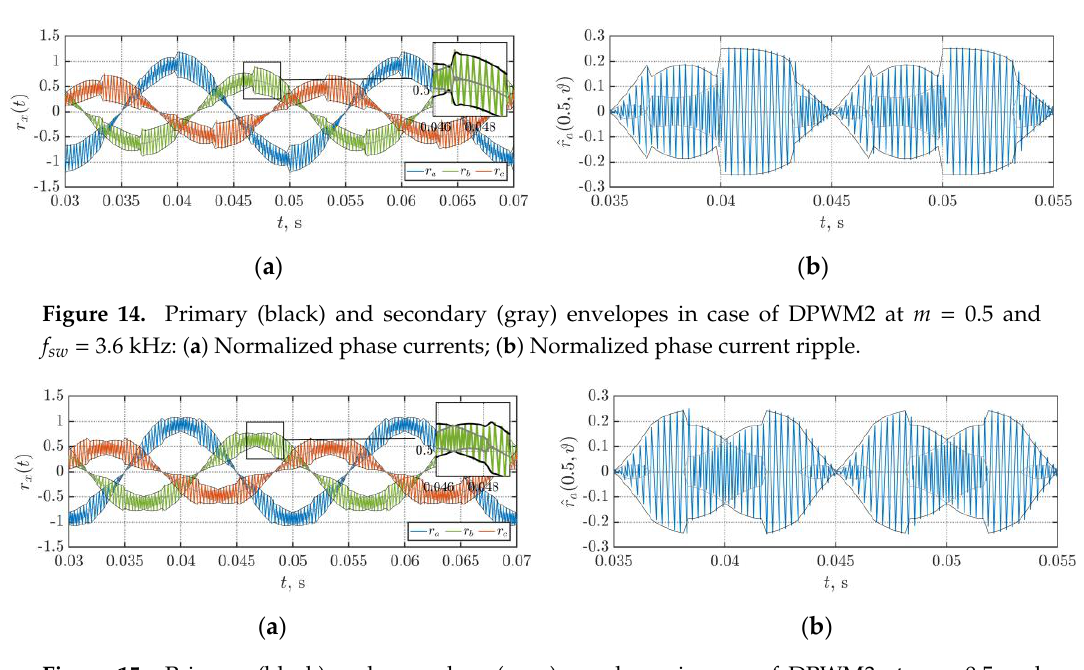
( d ) Figure 16. Normalized primary and secondary peak-to-peak phase current ripples in case of: ( a ) SPWM; ( b ) CPWM; ( c ) THIPWM1/6; and ( d ) THIPWM1/4.